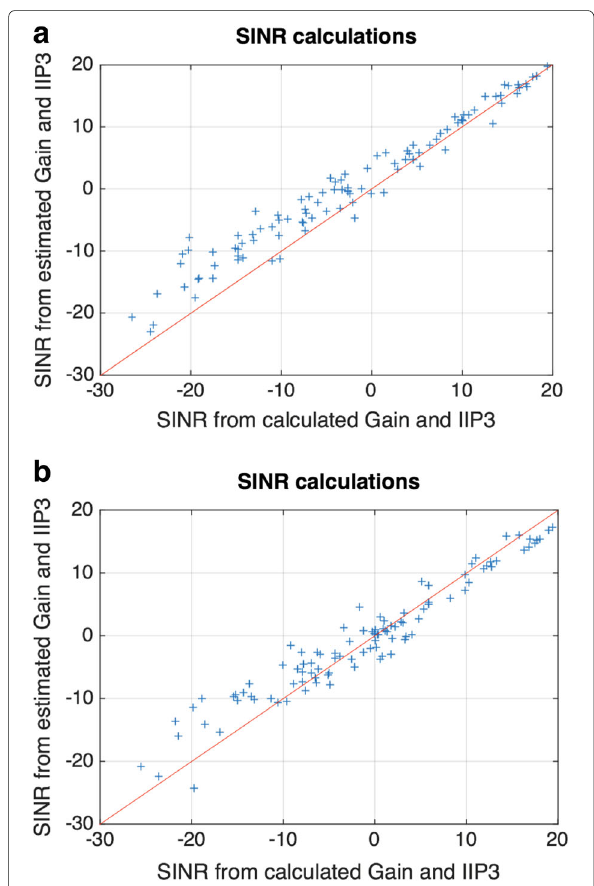
Fig. 10 SINR calculated using (10) in [11] a scenario 1: interference of the power − 30 dBm at 20 MHz frequency offset from the signal of interest of − 67 dBm and b scenario 2: two interferences of the power − 35 dBm at 150 and 300 MHz frequency offset, respectively, from the signal of interest of − 67 dBm